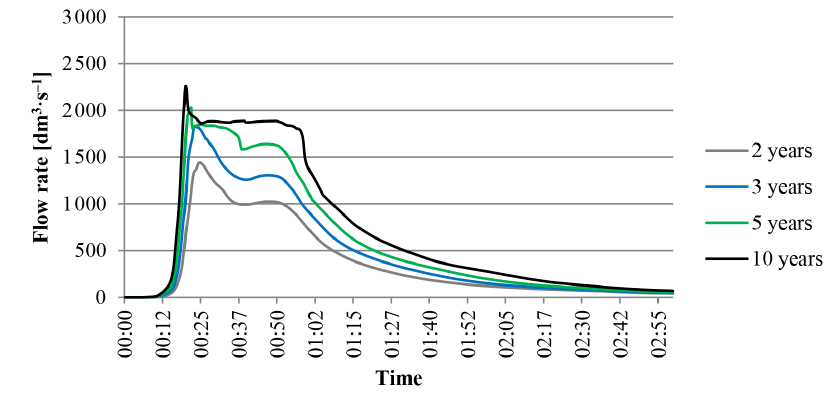
Figure 10. Change in the intensity of flow through channel Link-30 – after implementation